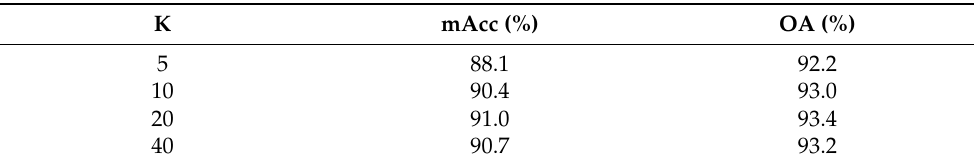
Table 5. Results of our classification network with different numbers k of nearest neighbors. K